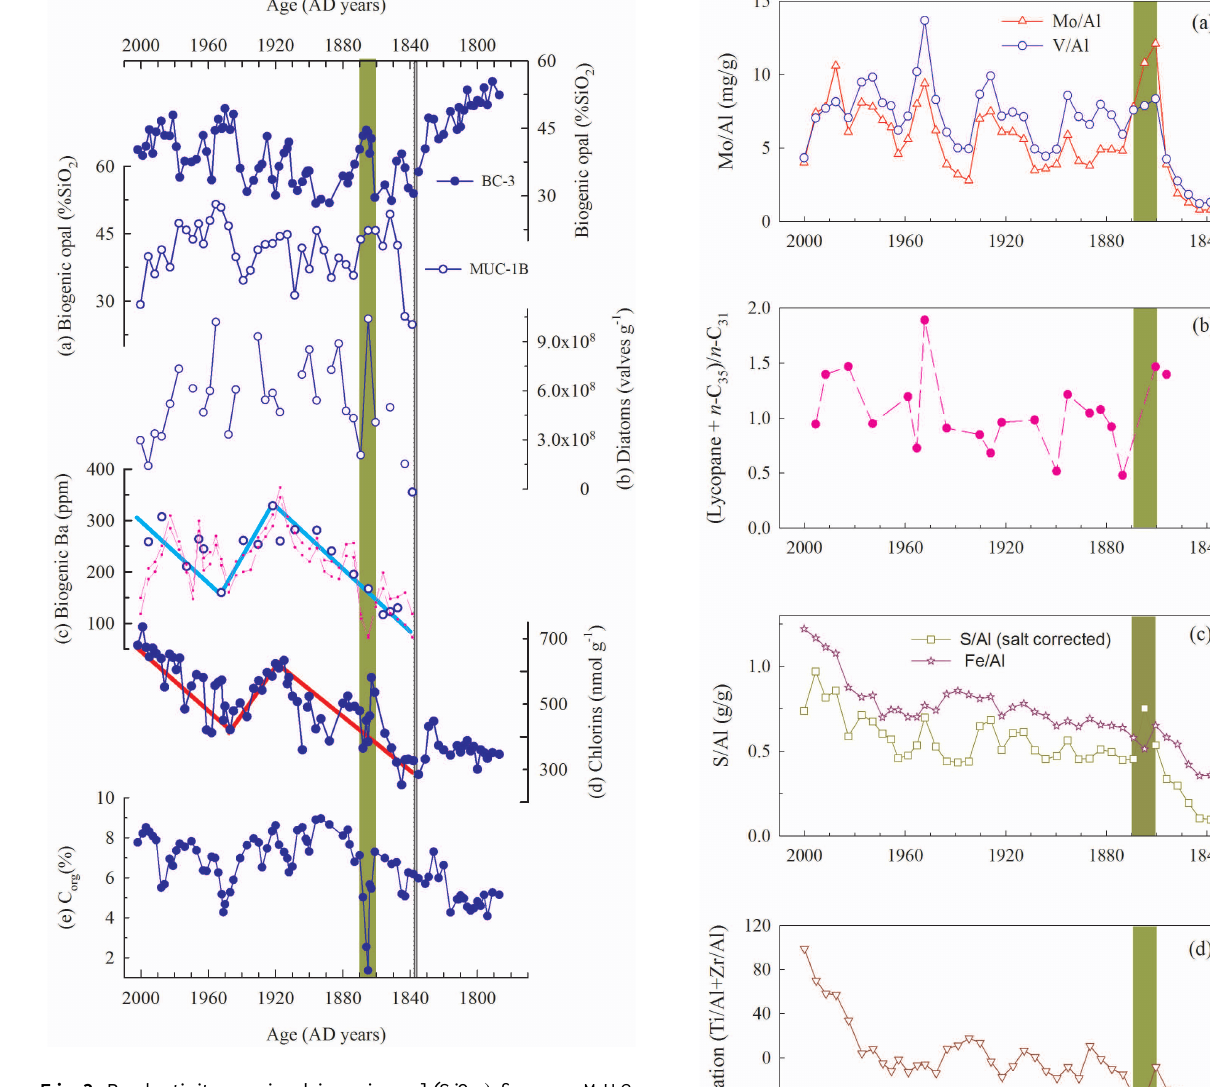
Fig. 3. Productivity proxies: biogenic opal (SiO 2 ) for cores MUC- 1B and BC-3D (a) , total diatom counts (MUC-1B) (b) , biogenic Ba (MUC-1B): [thin pink dashed lines correspond to upper and lower limits of biogenic barium (Ba bio computed from constant detrital Ba/Al of 0.001 to 0.003, corresponding to the range of direct extrac- tions (bioBa) (open circles)] (c) , chlorins (BC-3D) (d) , and organic carbon (C org , BC-3D) (e) . Common trends between biogenic Ba and chlorins are highlighted with blue and red lines, respectively. Green and shaded grey areas as in Fig. 2.